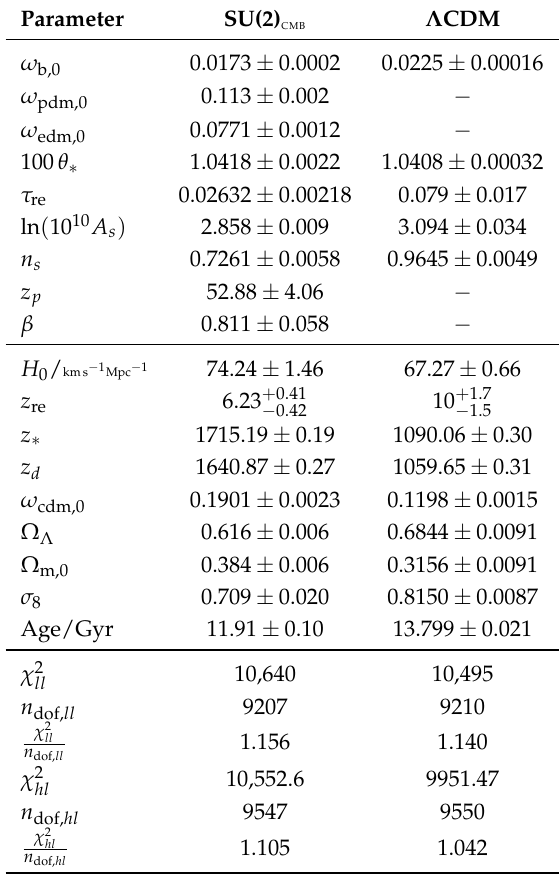
Table 1. Best-fit cosmological parameters of the SU(2) and the Λ CDM model as obtained in [34]. CMB The best-fit parameters of Λ CDM together with their 68% confidence intervals are taken from [8], employing the TT,TE,EE+lowP+lensing likelihoods. For SU(2) the HiLLiPOP+lowTEB+lensing CMB likelihood (lowP and lowTEB are pixel-based likelihoods) was used, see [55]. The central values + χ 2 associate with χ 2 = χ 2 (best fit) as quoted in the lower part of the Table. ll hl Λ Parameter SU(2) CMB